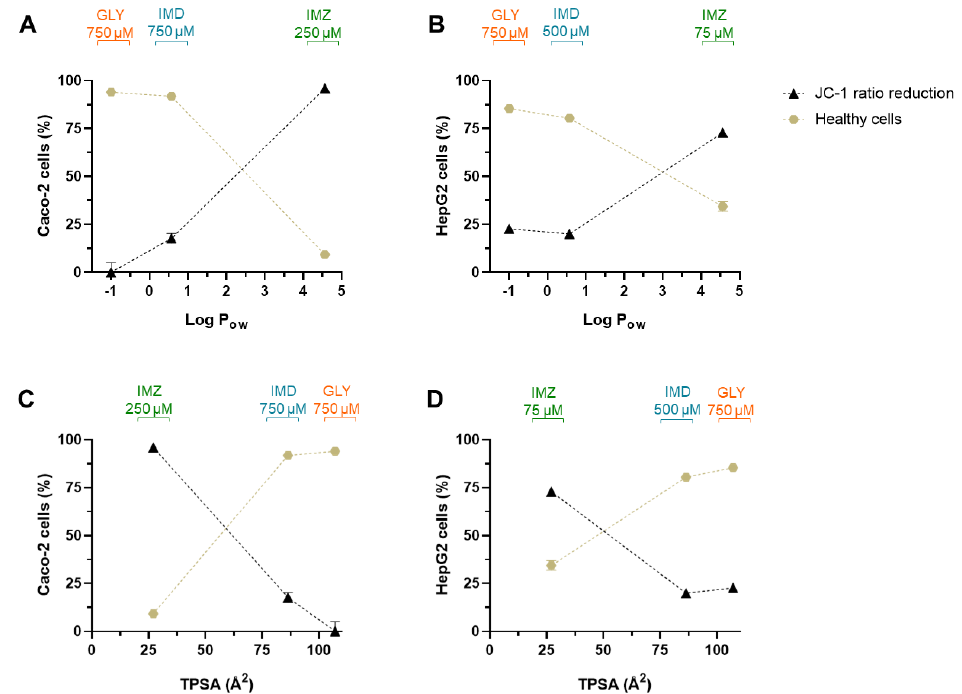
Figure 8. Correlation between loss of MMP (assessed as % in FL2/FL1 ratio reduction, in relation to negative control cells; obtained from Figure 5) and pesticides Log P ow ( A , B ) or with pesticides TPSA ( C , D ), for Caco-2 and HepG2 cells, as denoted. Moreover, correlations between the % of healthy cells (assessed in Annexin-V/PI assay, Figure 6) and pesticides Log P ow ( A , B ) and with pesticides TPSA ( C , D ), for Caco-2 and HepG2 cells as denoted. Loss of MMP and % of healthy cells are denoted by black triangles and brown circles, respectively.